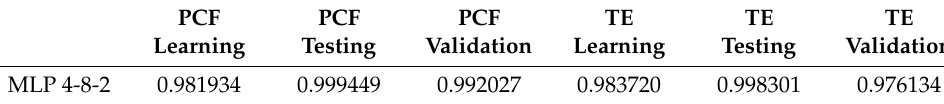
Figure 11. Graphical visualization of the applied neural network. Table 4. Quality of the MLP neural network for the absorber with a hexagonal trigger.